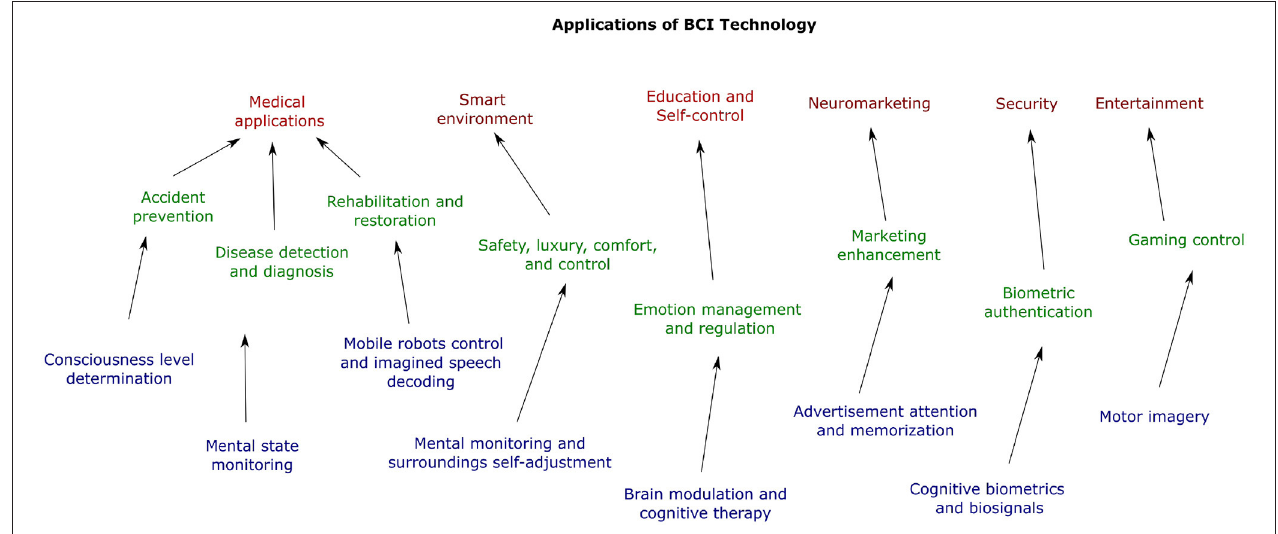
FIGURE 1 | Technology map of BCI